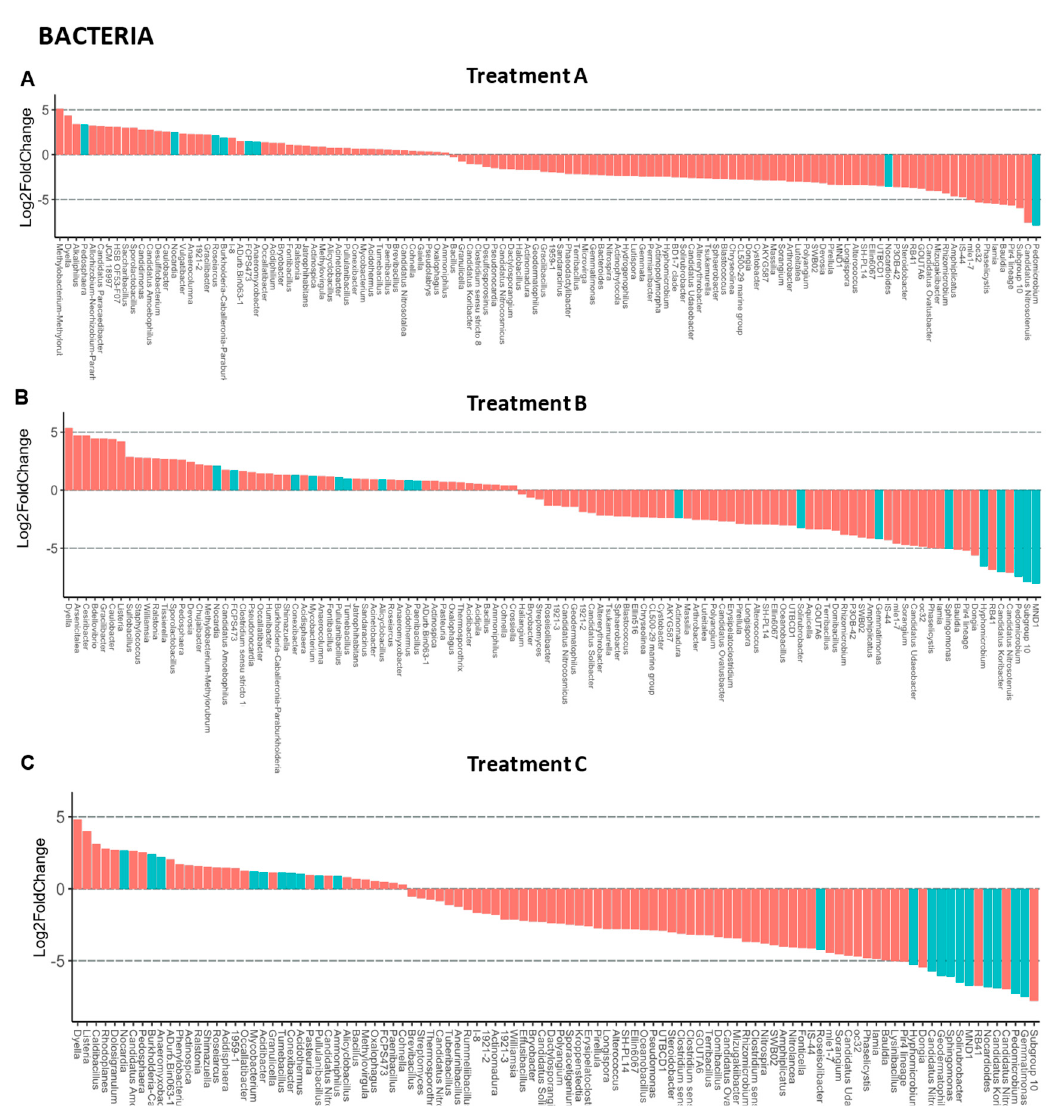
Figure 6. Changes in the relative abundance of the bacteria genera as a function of treatments A ( A ), B ( B ), and C ( C ). The Y-axis represents the log2FoldChange. Only genera with p -values < 0.6 are depicted.